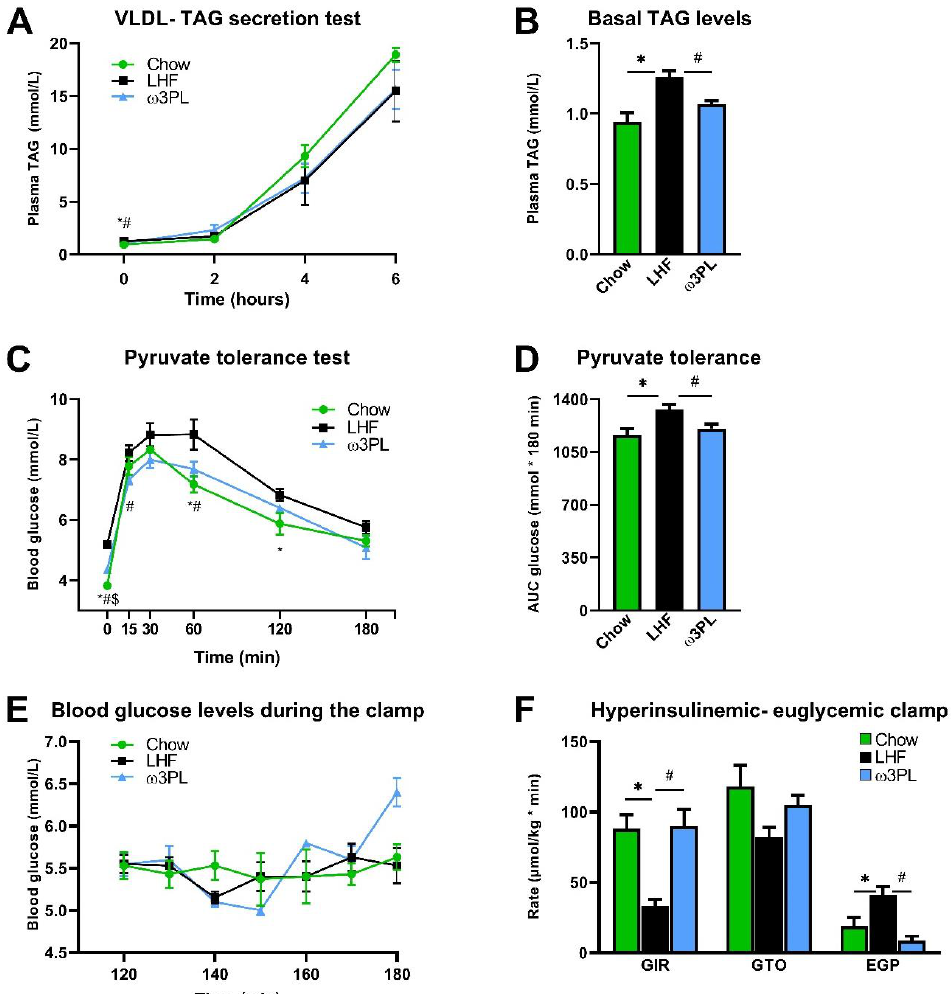
Figure 6. Effect of krill oil supplementation on hepatic VLDL-TAG production ( A ), fasting plasma TAG levels ( B ), glycemia during the pyruvate tolerance test ( C ), the level of pyruvate-driven gluconeogenesis ( D ), as well as glycemia during the last hour of hyperinsulinemic-euglycemic clamp ( E ) and clamp-related parameters including glucose infusion rate (GIR), glucose turnover (GTO) and endogenous glucose production (EGP; F ). Data are means ± SEM ( n = 6–7). *, significant difference between LHF and Chow; #, significant difference between LHF and ω3PL; $, significant difference between ω3PL and Chow (one-way ANOVA or Kruskal–Wallis).